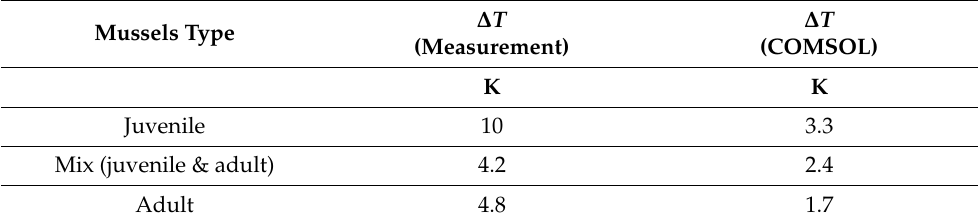
Table 9. The temperature difference between the mussel layer’s inner and outer